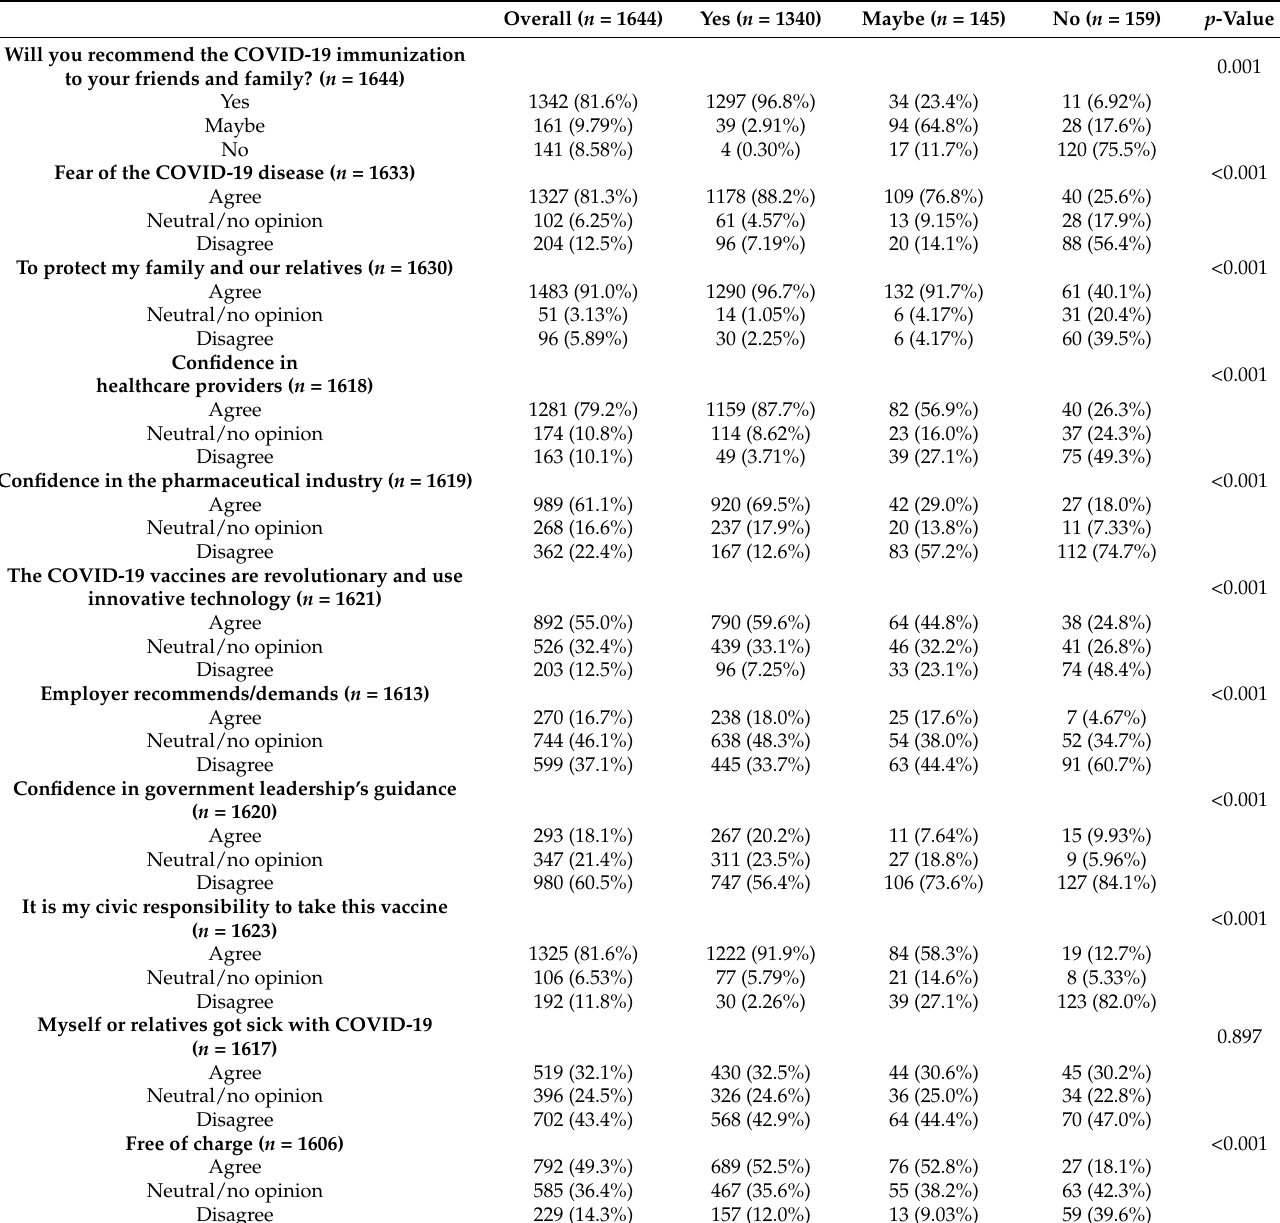
Table 4. Reasons for taking, or not taking, the COVID-19 vaccine as stated by the participants in the survey. Overall ( n =